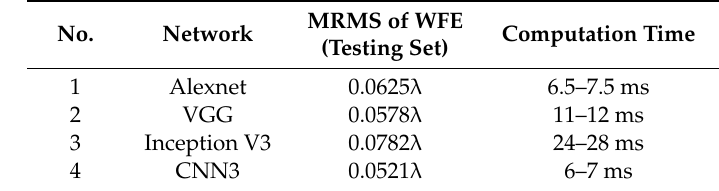
Table 4. The results of the experiment.